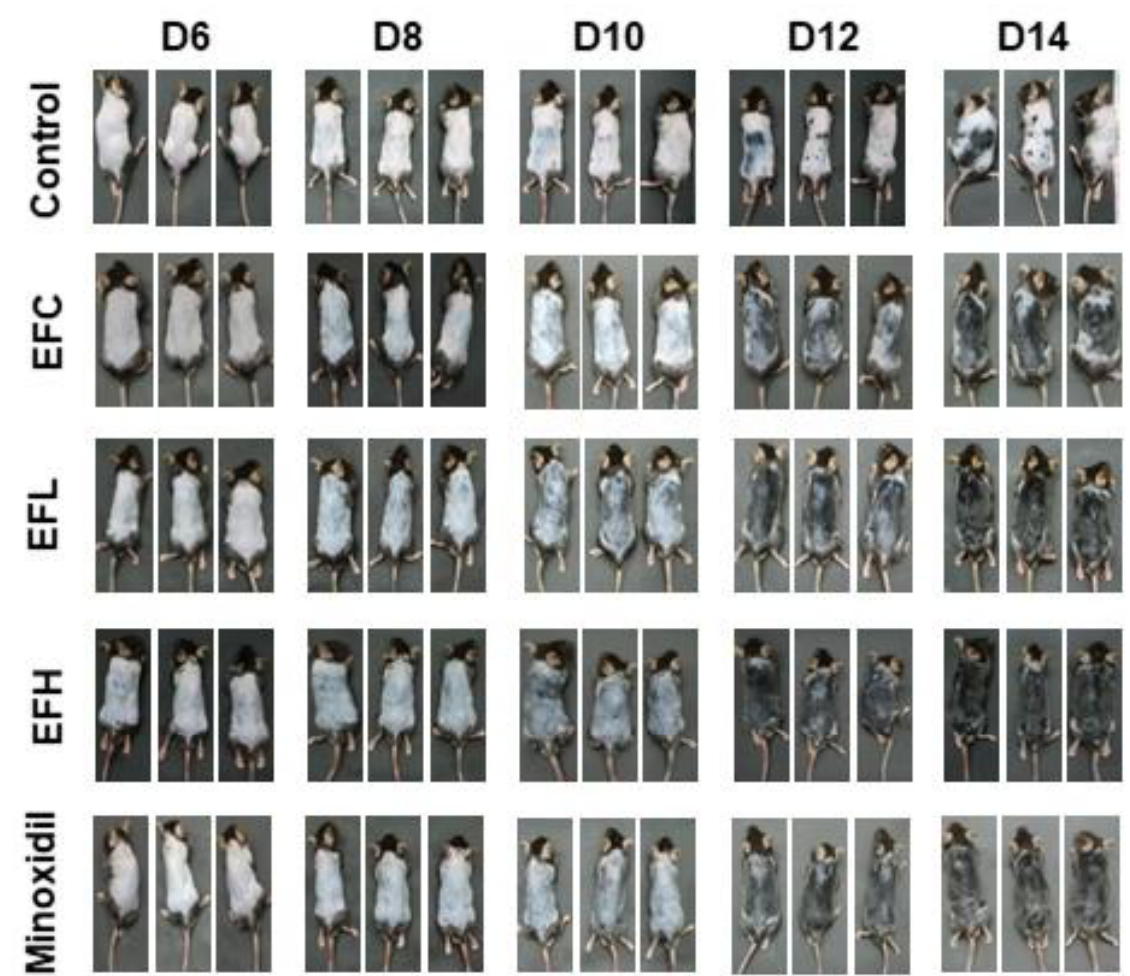
Figure 2. Comparison of hair regrowth in C57BL/6 male mice after topical application of phosphate- buffered saline (PBS), minoxidil (5%), or EF-2001 (0, 5, 50 mg/mL) for 6, 8, 10, 12, and 14 d. Hair growth on the dorsal skin of C57BL/6 mice after treatment for 14 d with control (PBS, n = 7), EFC (solvent control, 0 mg/mL of EF-2001 in 3:1 mixture of acetone and olive oil), EFL (EF-2001 low concentration, 5 mg/mL of EF-2001 in 3:1 mixture of acetone and olive oil), EFH (EF-2001 high concentration, 50 mg/mL of EF-2001 in 3:1 mixture of acetone and olive oil), and minoxidil (5% minoxidil, n = 7). Dorsal skin was photographed at 6, 8, 10, 12, and 14 d of treatment. Images were obtained using a Galaxy S10 Plus camera (Samsung, Seoul, Korea).